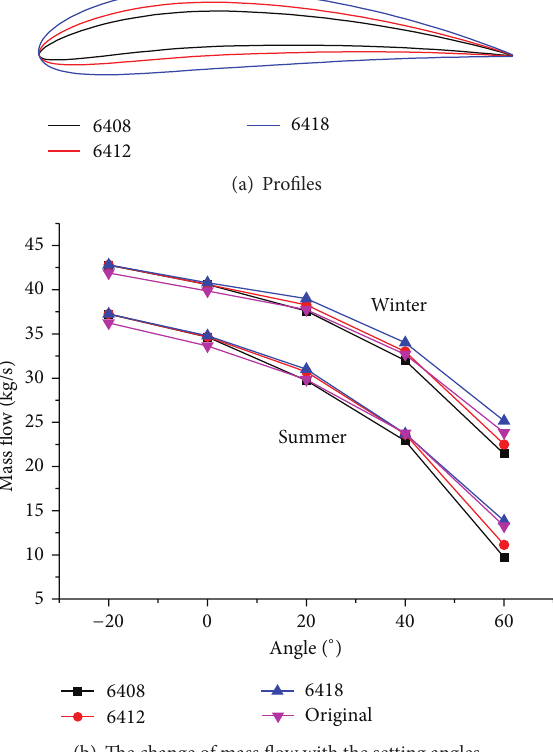
Figure 14: Camber guide vanes with different